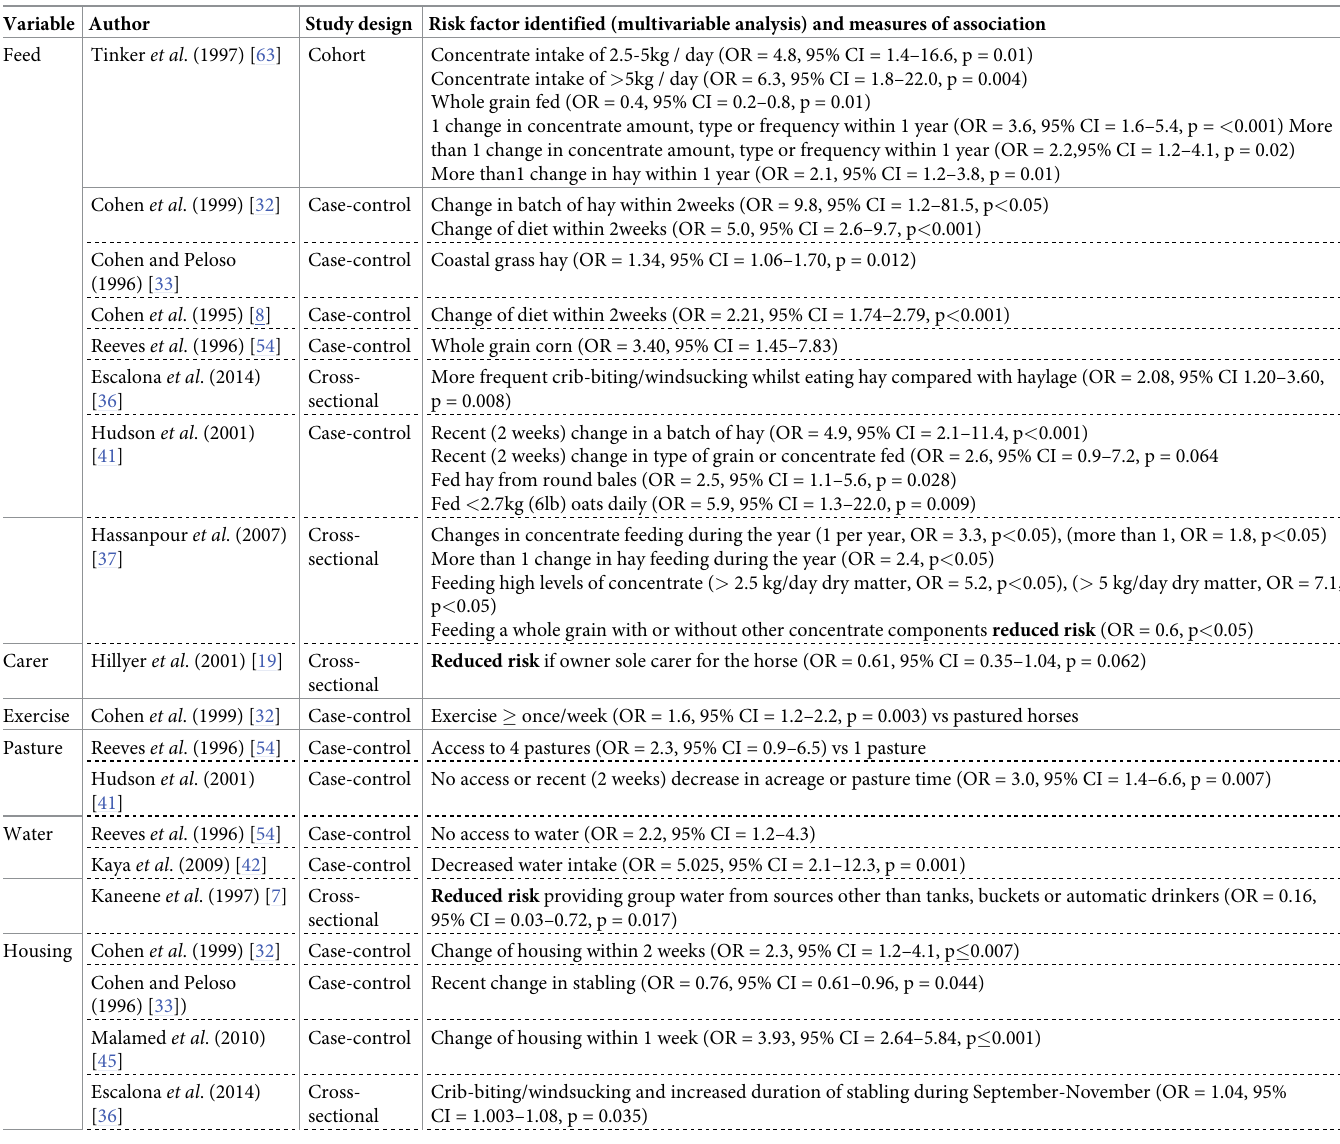
Table 8. Statistically significant results of included publications from a systematic review of management risk factors for colic in the horse. Study design Risk factor identified (multivariable analysis) and measures of